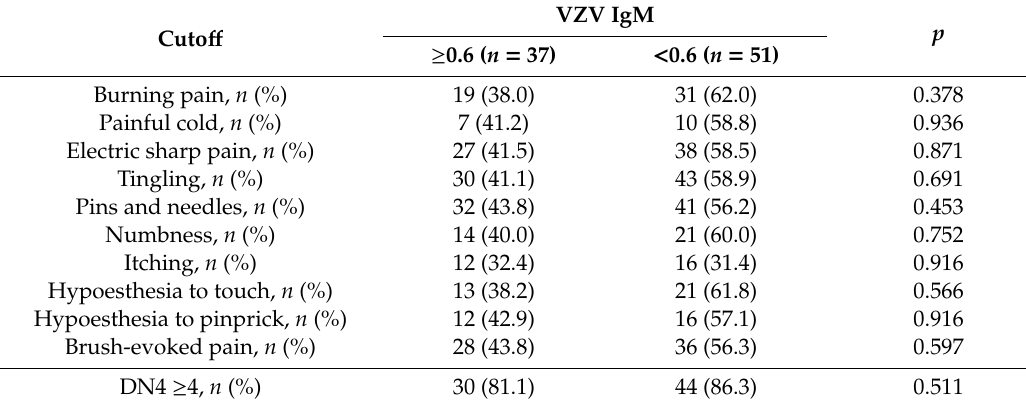
Table 5. Proportions of items in the DN4 questionnaire between patients with VZV IgM titer ≥ the cuto ff value vs. < the cuto ff